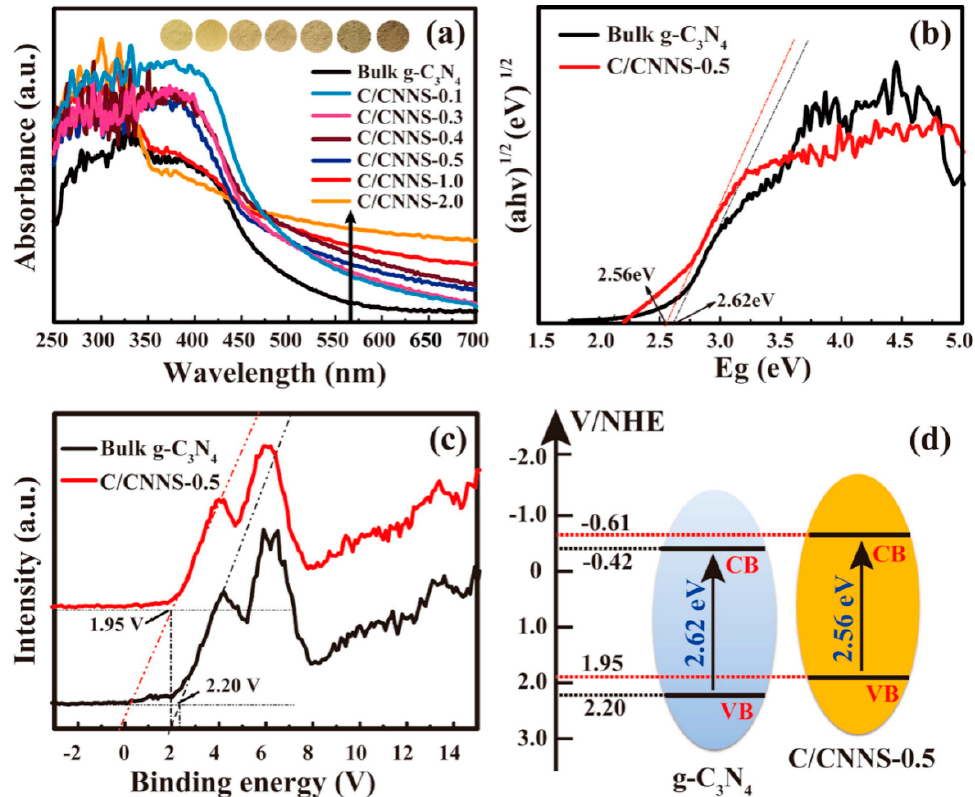
Figure 5. Ultra-violet di ff use-reflectance spectra of bulk g-C3N4, C / CNNS-x (x = 0.1, 0.3, 0.4, 0.5, 1.0, 2.0) ( a ), the band gap plots ( b ), valence band (VB) XPS spectra ( c ), and the band structure diagrams of bulk g-C3N4 and C / CNNS-0.5 photocatalysts ( d ). Reprinted from [79], Copyright (2019), with permission from Elsevier.